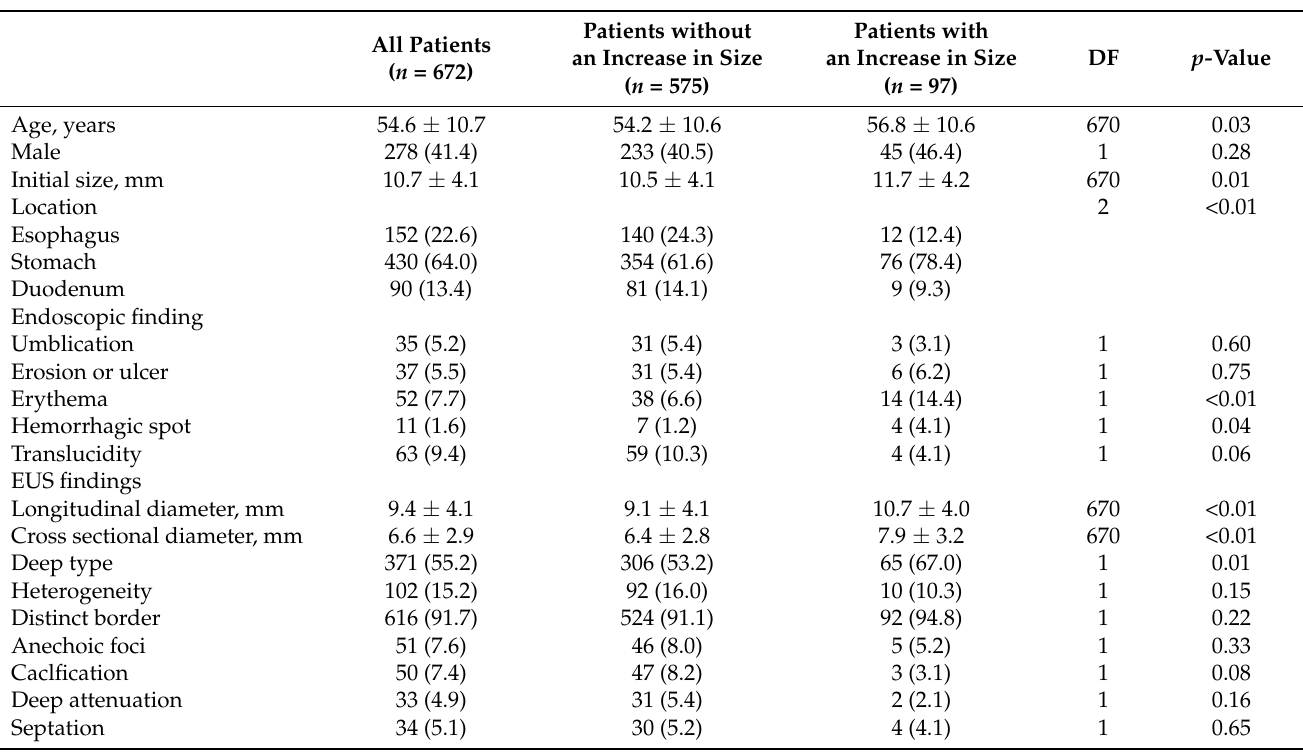
Table 1. Demographic, endoscopic and ultrasonographic findings of 672 patients with upper gas- trointestinal subepithelial lesions.